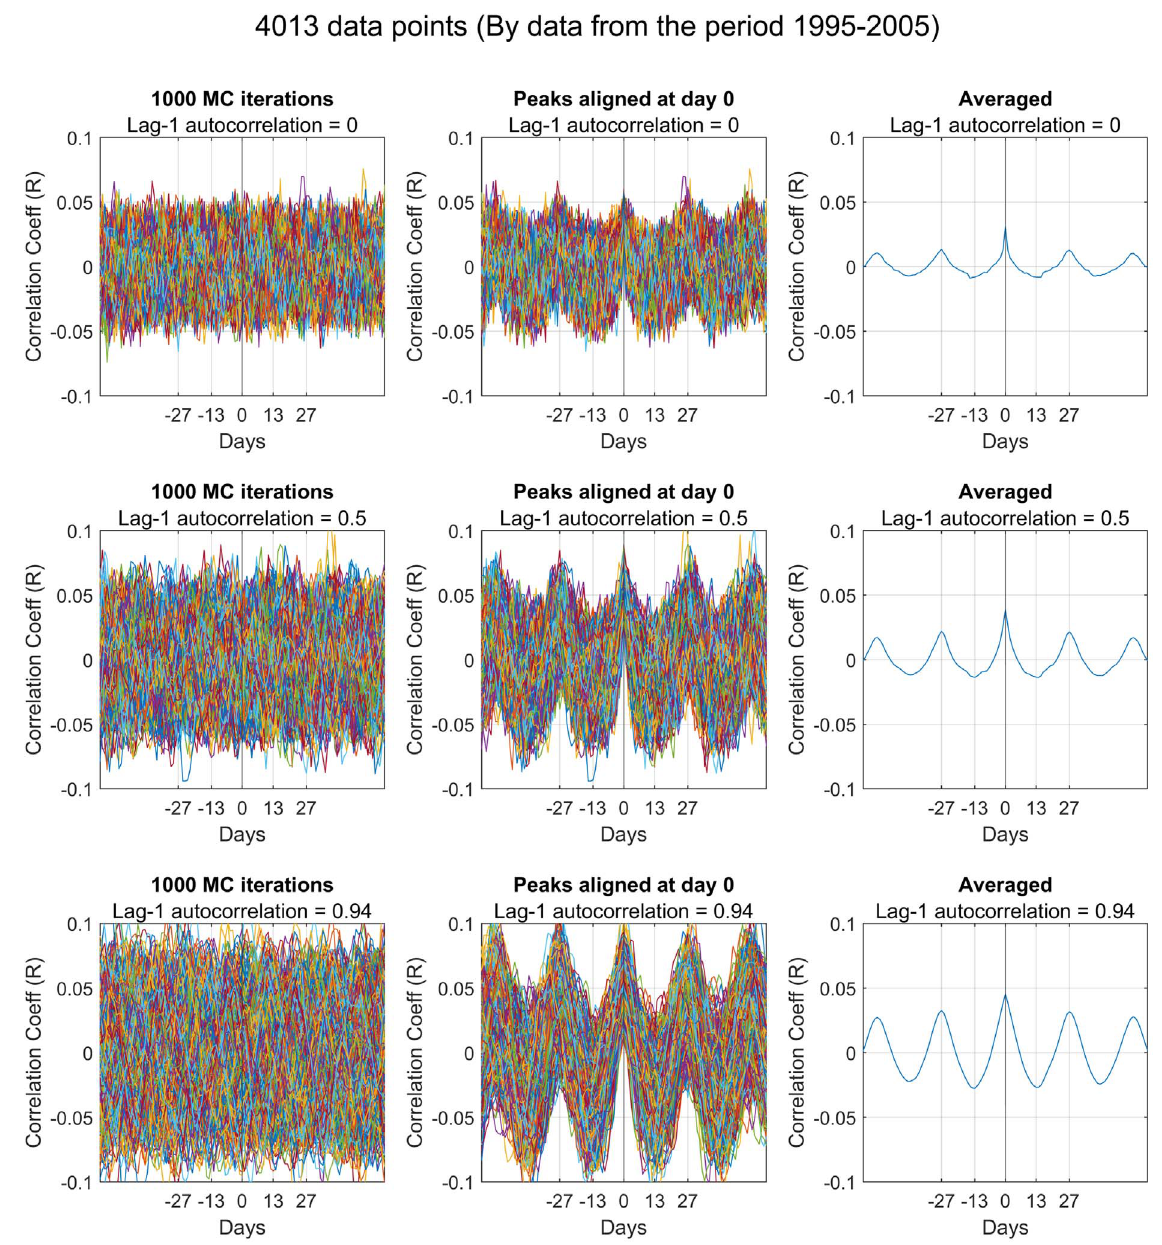
Fig. 9. Left panels : 1000 MC iterations where the correlation coef fi cients are calculated between the B y data in the period 1995 – 2005 and normally distributed noise with three different lag-1 autocorrelation values (0, 0.5, 0.94) for every lead – lag between (cid:1) 60 and +60. Middle panels : All 1000 individual lead – lag plots aligned such that the maximum value within (cid:1) 13 to +13 is projected to day 0. Right panels : Averaged response of the middle